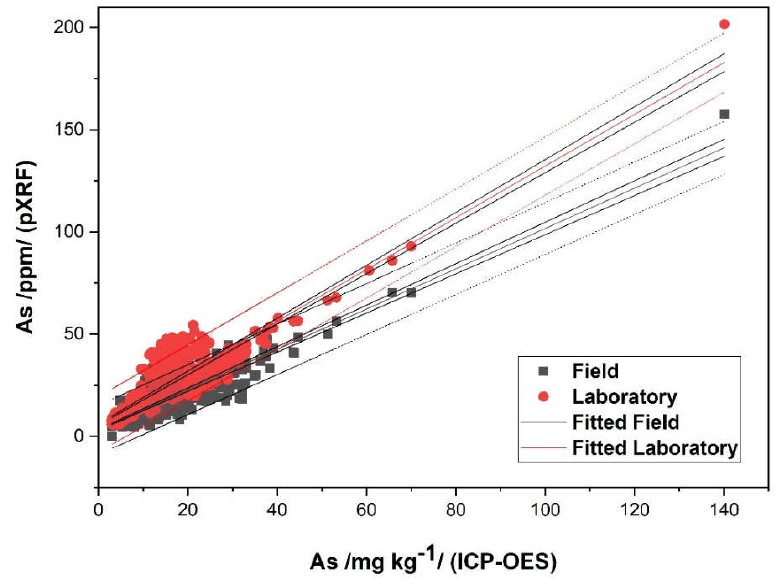
Figure 1. Statistical significance of regression model for Arsen (pXRF) in soil samples from experimental soil sites from Otava and Mže river basins measured in FIELD and LABORATORY.